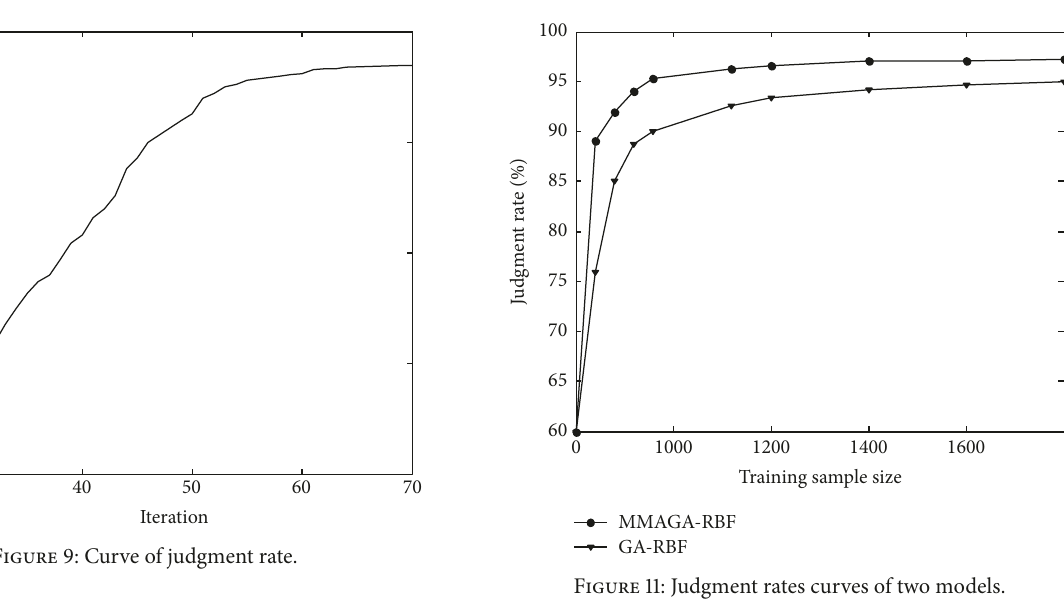
Figure 11: Judgment rates curves of two